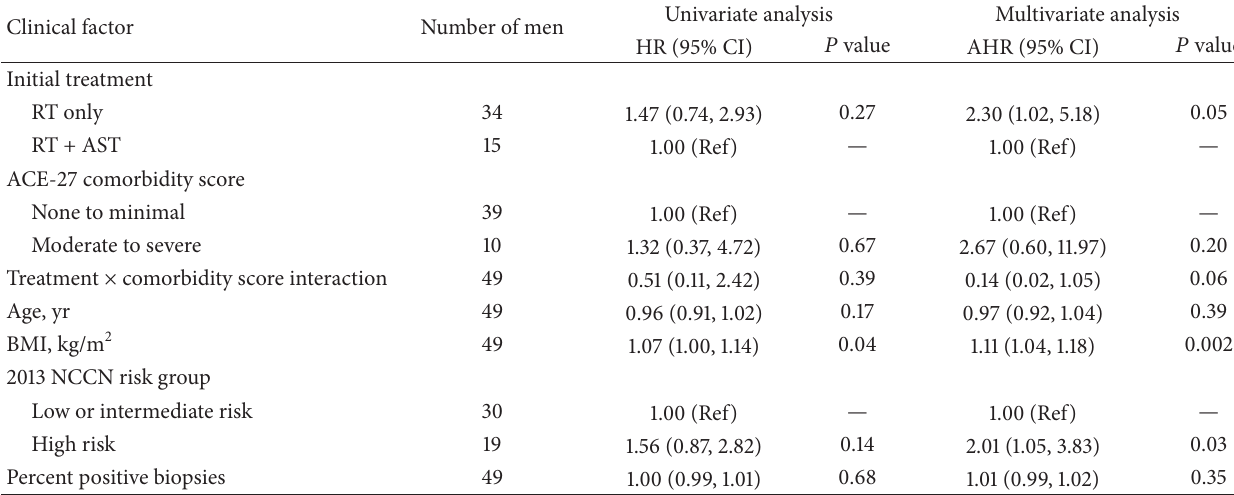
Table 2: Cox regression unadjusted and adjusted hazard ratios for clinical factors predicting for the risk of receipt of sAST. Clinical factor Number of